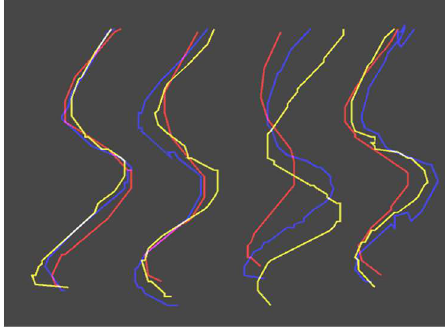
Fig. 27 No warning vs warning; order of experiment: